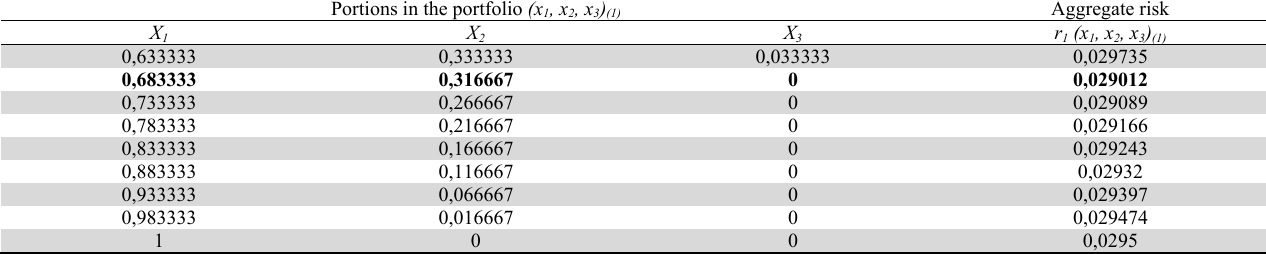
Fragment of the decision table in forming the optimal structure of the investment program (strategy 2) Portions in the portfolio (x 1 , x 2 , х 3 ) (1)